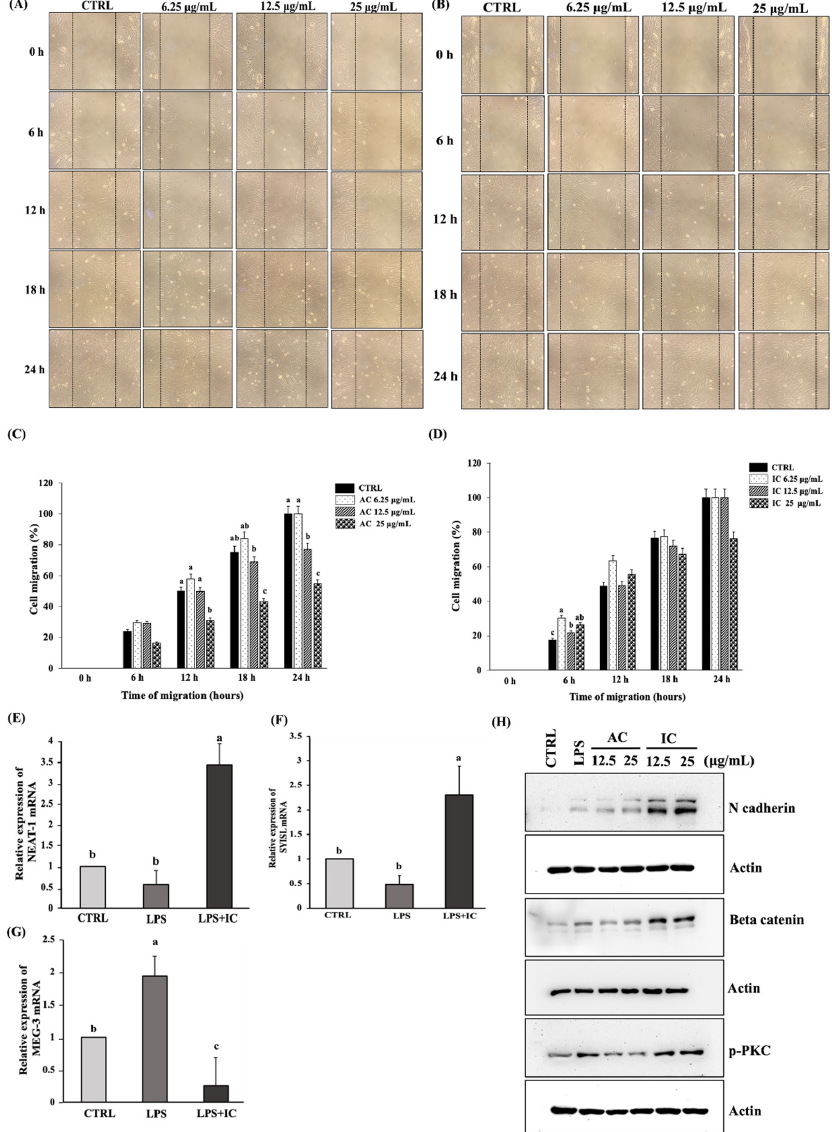
Figure 7. IC influences the lncRNAs expression to promote the migration and proliferation of C2C12 myoblast cells. Wound healing assay performed on myoblasts treated with 6.25 µg/mL, 12.5 µg/mL, and 25 µg/mL of ( A ) AC and ( B ) IC with respect to time (0 h, 6 h, 12 h, 18 h, and 24 h) visualized using a microscope. The percentage cell migration calculated on myoblasts treated with ( C ) AC and ( D ) IC with respect to time. The influence of IC on the lncRNA expression in C2C12 myoblasts was analyzed using RT-PCR study. The cells were treated with 25 µg/mL of IC followed by LPS treatment, RNA extraction, and cDNA synthesis. The RT-PCR analysis was carried out to determine the effect of IC on ( E ) lncRNA NEAT-1, ( F ) lncRNA SYISL, and ( G ) lncRNA MEG-3 expression. ( H ) The effect of IC on the expression of migratory proteins was studied by western blot analysis. The study was repeated three times, and the results were shown as mean ± SD; n = 3. The statistical comparison between groups was performed using One-way ANOVA (Dunnett’s multiple comparisons test).abc indicate significant differences between the groups. Statistically different groups are denoted by different letters and different groups of letters. Similar letters and similar groups of letters denote no statistical difference between